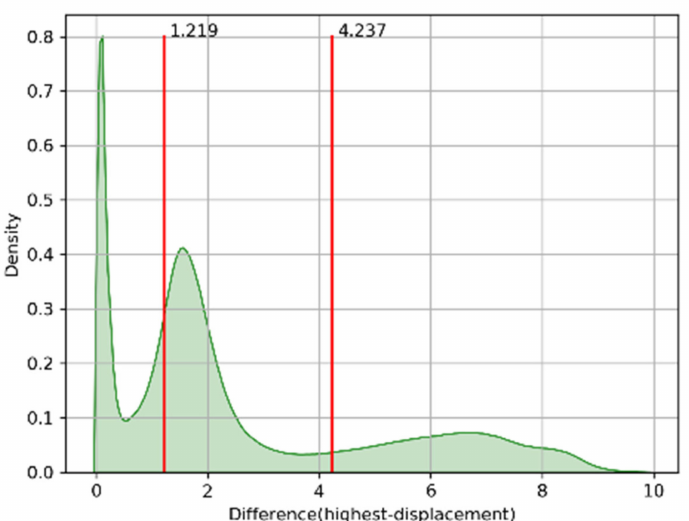
Figure 6. Kernel Density Estimation (KDE) of the difference between the target and minimum TOA reflectance. The red lines indicate the threshold values calculated from the Otsu multi-threshold method. We used the threshold on the right side. The number of data points was 65,609,628, which were stacked over 30 days in land and sea